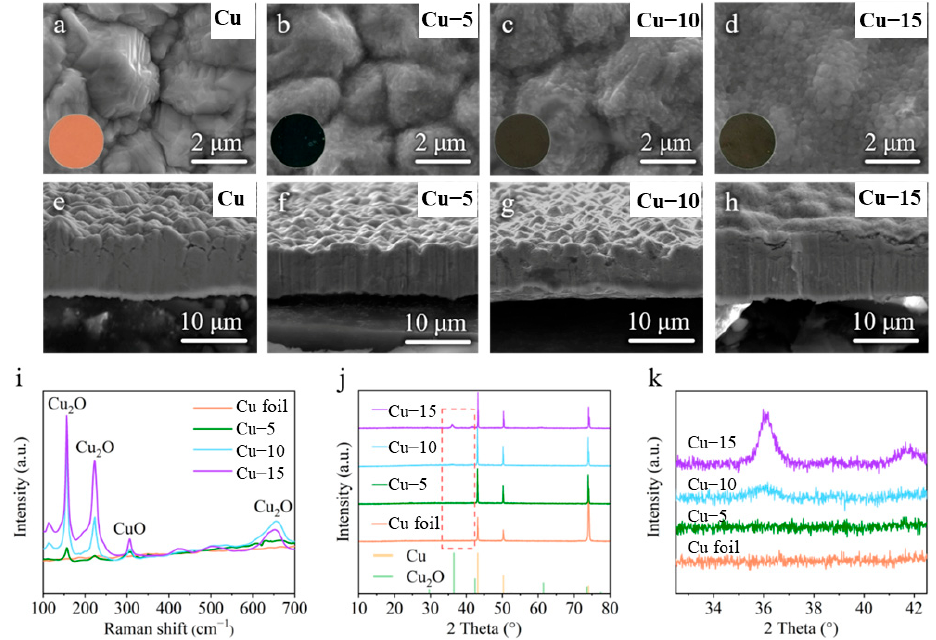
Figure 1. ( a – d ) Surface and ( e – h ) cross-sectional SEM images of the ( a , e ) commercial Cu foil, ( b , f ) Cu − 5, ( c , g ) Cu − 10 and ( d , h ) Cu − 15. The inset is the corresponding optical photos. ( i ) Raman spectra of different Cu foils. ( j ) XRD patterns and ( k ) the partially enlarged drawing at 33–42° of different Cu foils.